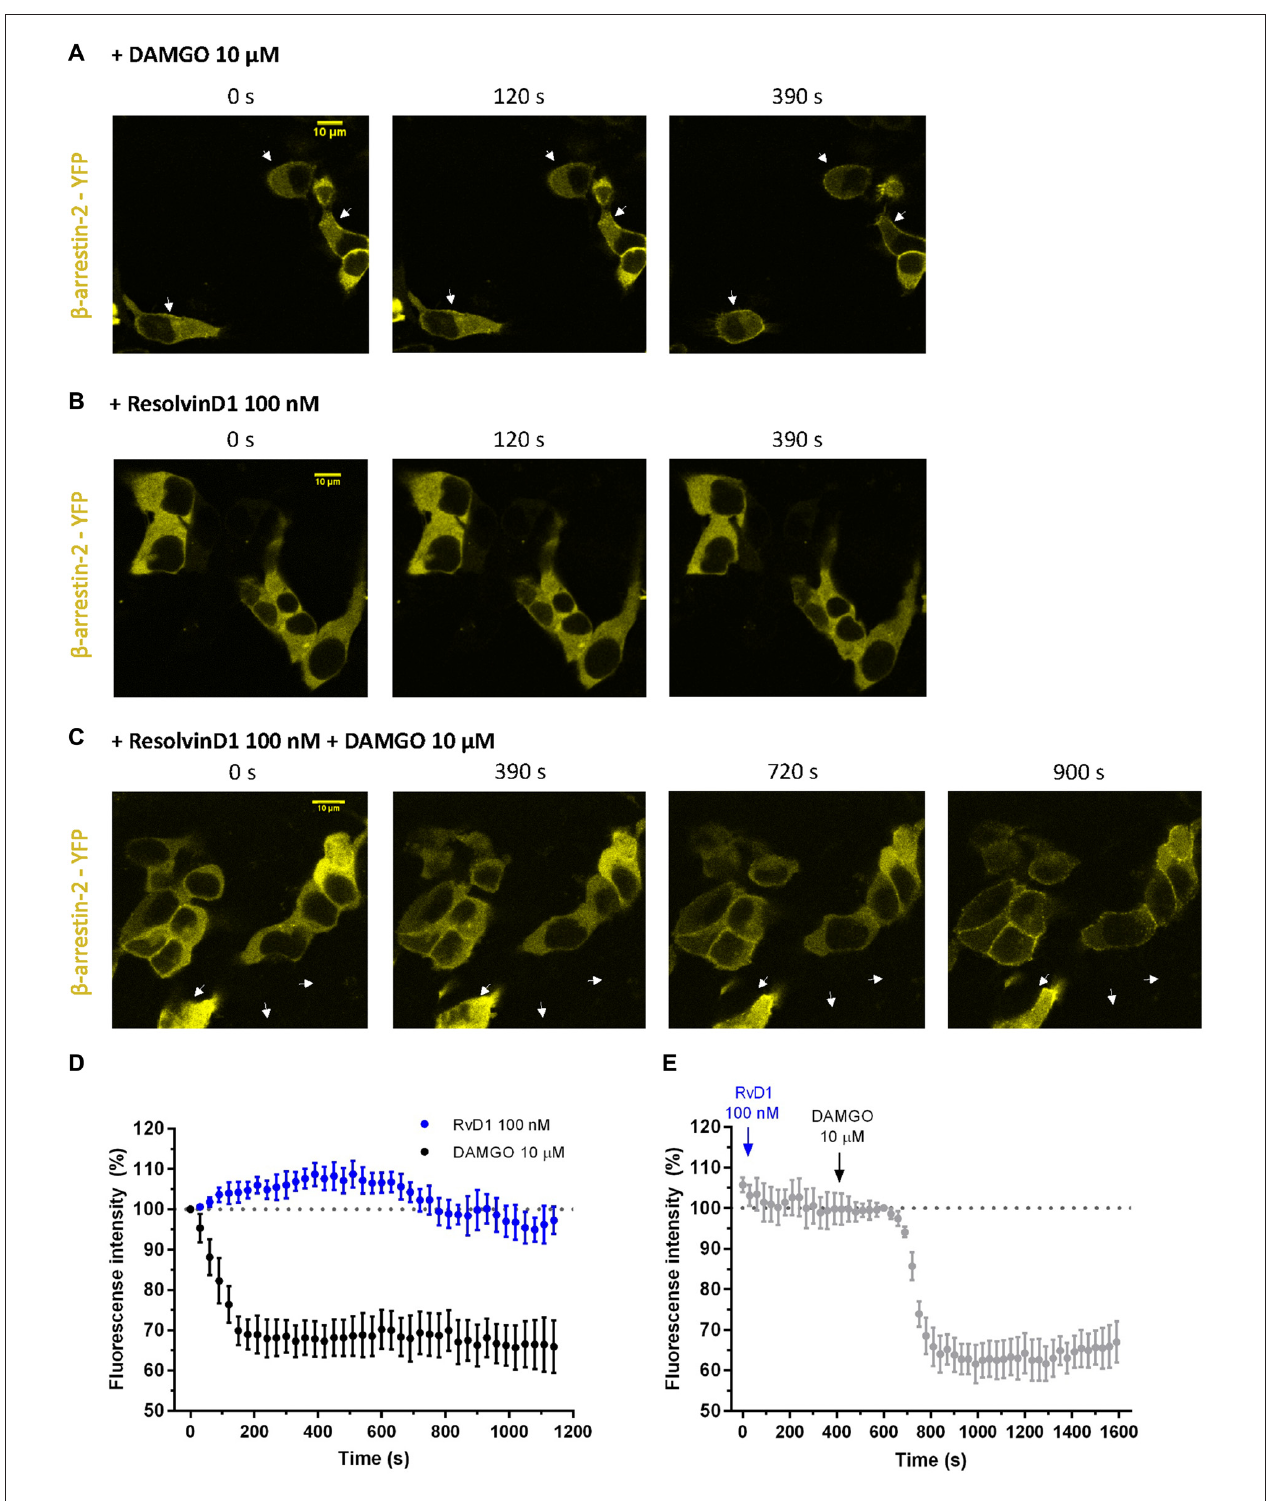
FIGURE 5 | β -arrestin-2 recruitment mediated by MOP in response to DAMGO or/and ResolvinD1. Representative images from HEK-293 cells transfected with MOR-CFP, GRK2, and β -arrestin-2-yellow fluorescent protein (YFP), are shown at different time points (0, 120, 390, 720 or 900 s) upon application of the indicated concentration of ligand: 10 µ M DAMGO (A) , 100 nM RvD1 (B) or 100 nM RvD1 followed by addition of 10 µ M DAMGO after 450 s (C) . Arrows indicate β -arrestin-2 recruitment. (D,E) Images were quantified and corrected for photobleaching of the sample (DAMGO = 7 cells; RvD1 = 8 cells; RvD1 + DAMGO = 10 cells).